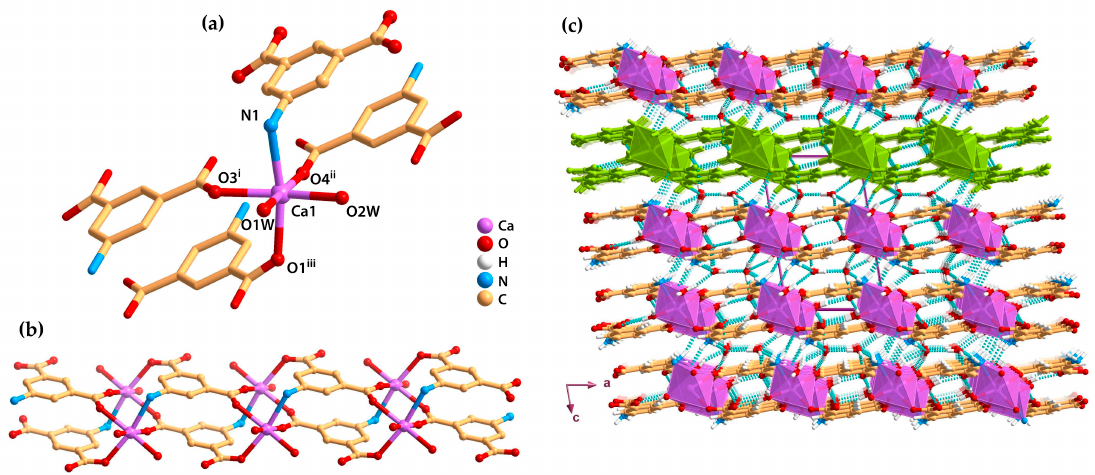
Figure 3. ( a ) Complete coordination environment for the Ca1 center in the crystal structure of [Ca(aip)(H 2 O) 2 ] · (H 2 O) ( 3 ), with the labelling scheme for all the atoms of the coordination sphere; ( b ) 1D metal-organic chain with ladder arrangement; ( c ) extended packing arrangement of 3 viewed in the [0 1 0] direction of the unit cell, with one supramolecular layer drawn in green color and N − H ··· O and O − H ··· O hydrogen bonds showed as the light-blue dashed line.